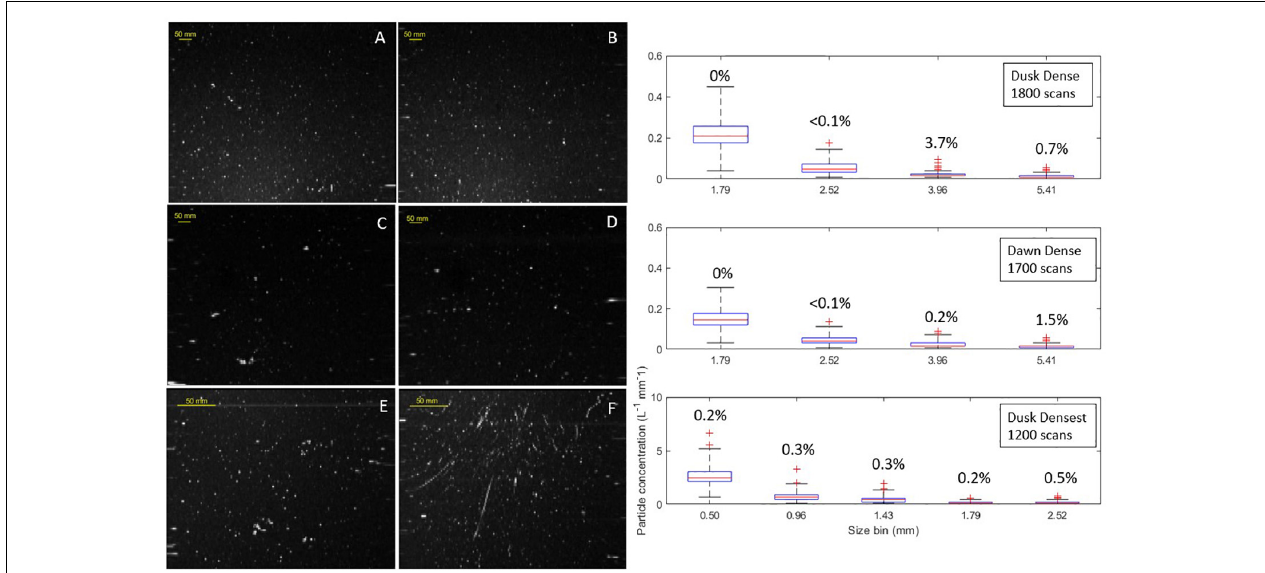
FIGURE 6 | Gray scale images containing anomalous particle enhancements taken in dense scan mode for dusk (A,B) and dawn (C,D) stations, similarly images taken in densest scan mode for dusk station (E,F) . Box and whisker plots per size bin for dense and densest scan modes on right with percentage of particle enhancement events provided above box and whiskers (see text for details).